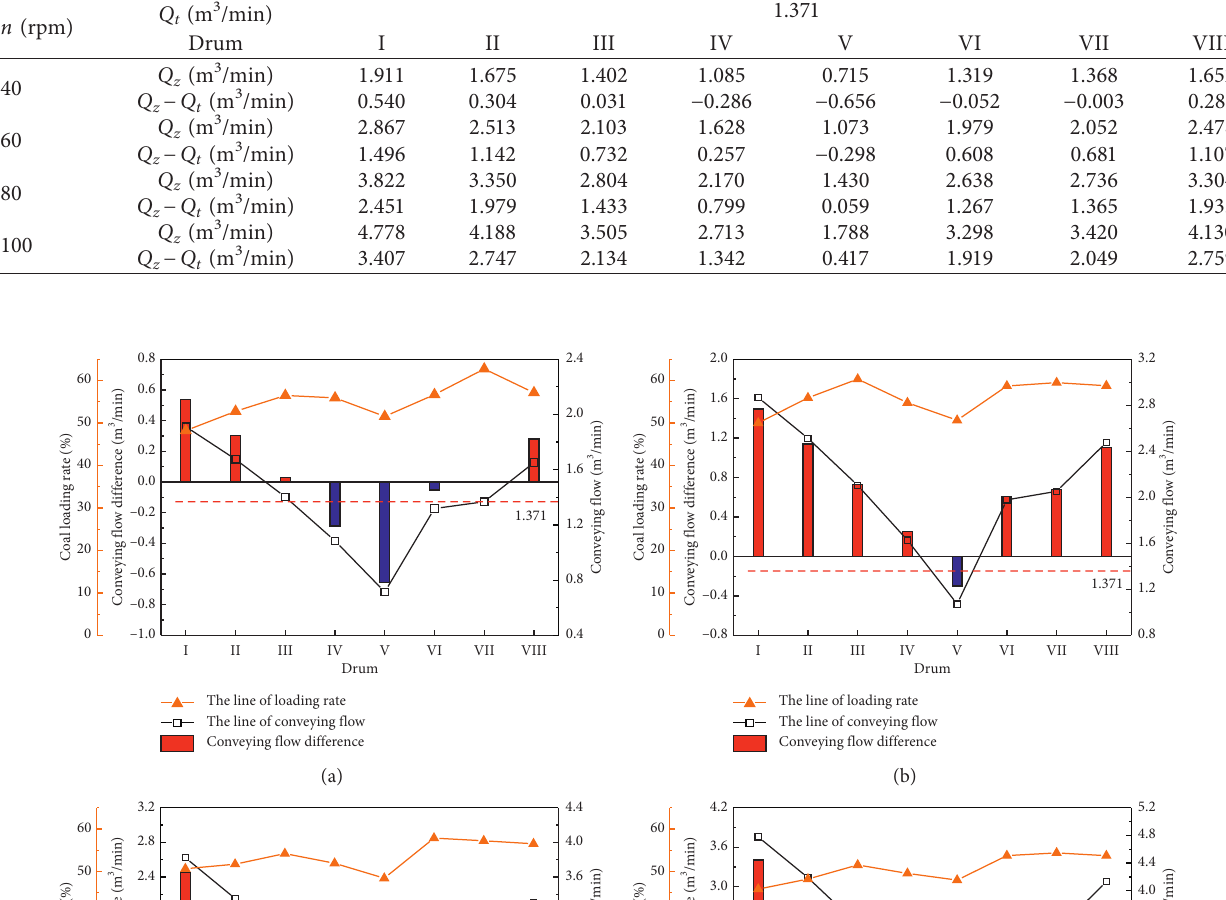
Table 4: The difference between conveying flow rate and cutting rate of drums with different rotational speeds.